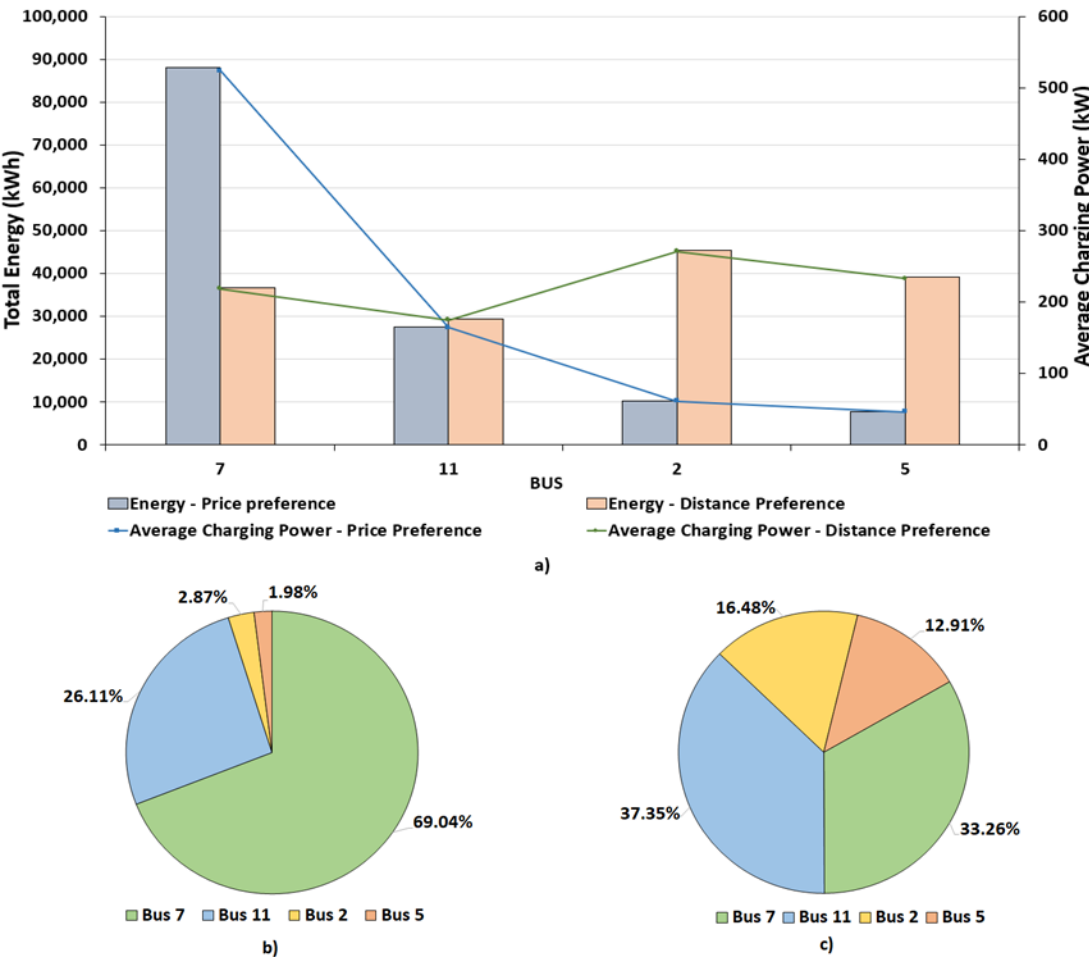
Figure 13. Energy and preference results in each bus that had parking lots for EV charging, considering the dynamic EV charging price in Case L. ( a ) Energy and average charge power at each EV parking lot bus. ( b ) Preference percentage for each parking lot bus considering the user price preference scenario. ( c ) Preference percentage for each parking lot bus considering the user distance preference